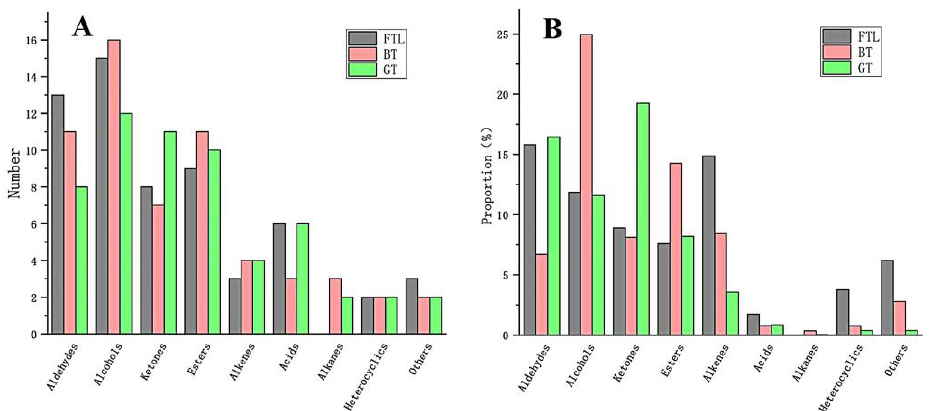
Figure 4. Volatile profiles of three tea samples. ( A ) The number of volatile compounds of different categories identified by GC-MS in three tea samples. ( B ) The proportion of volatiles of different categories identified by GC-MS of three tea samples.